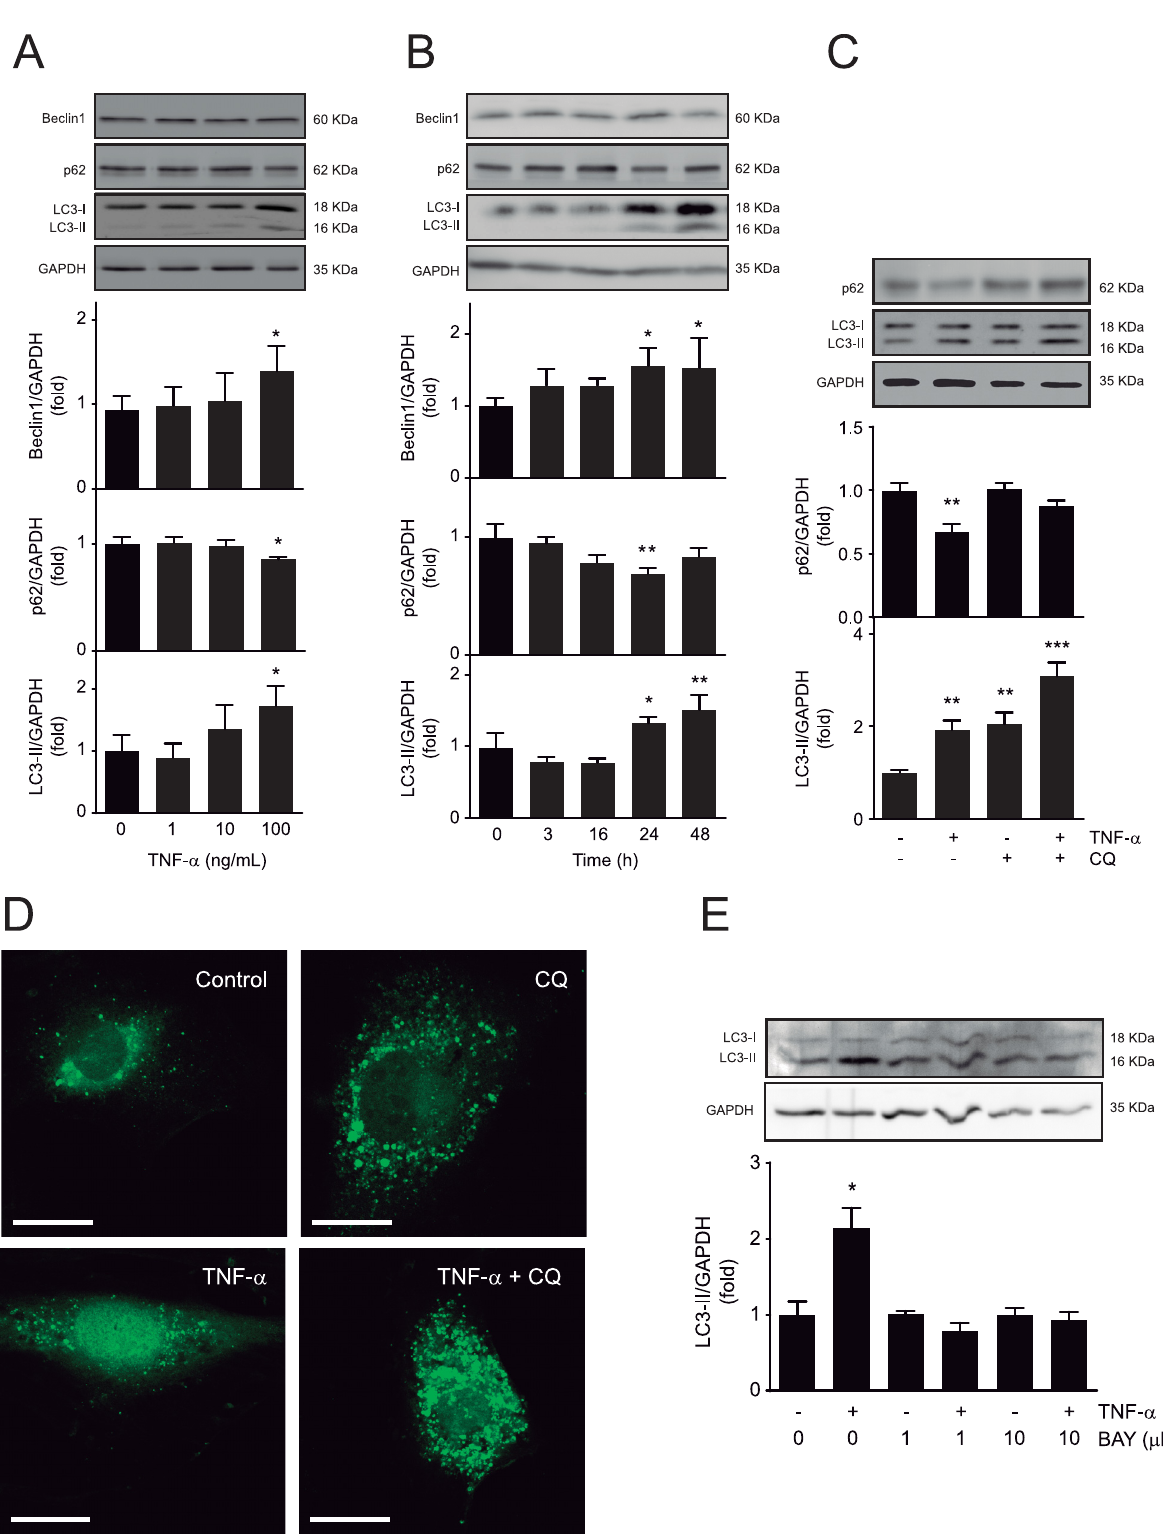
Fig 1. TNF- α activates autophagy in A7r5 cells through an-IKK α dependent pathway. ( A ) Western blot analysis of Beclin1, p62, LC3-II and GAPDH in A7r5 cells stimulated with 0, 1, 10 and 100 ng/mL of TNF- α (n = 4; (cid:3) p < 0.05 vs 0 ng/mL TNF- α ). ( B ) Western blot analysis of Beclin1, p62, LC3-II and GAPDH in A7r5 cells incubated with TNF- α (100 ng/mL) at 0, 3, 16, 24 and 48 h (n = 4; (cid:3) p < 0.05, (cid:3)(cid:3) p < 0.01 vs 0 h). ( C ) Western blot analysis of p62, LC3-II and GAPDH in A7r5 cells treated with TNF- α (100 ng/mL) for 24 h and co-administered with or without chloroquine (CQ,